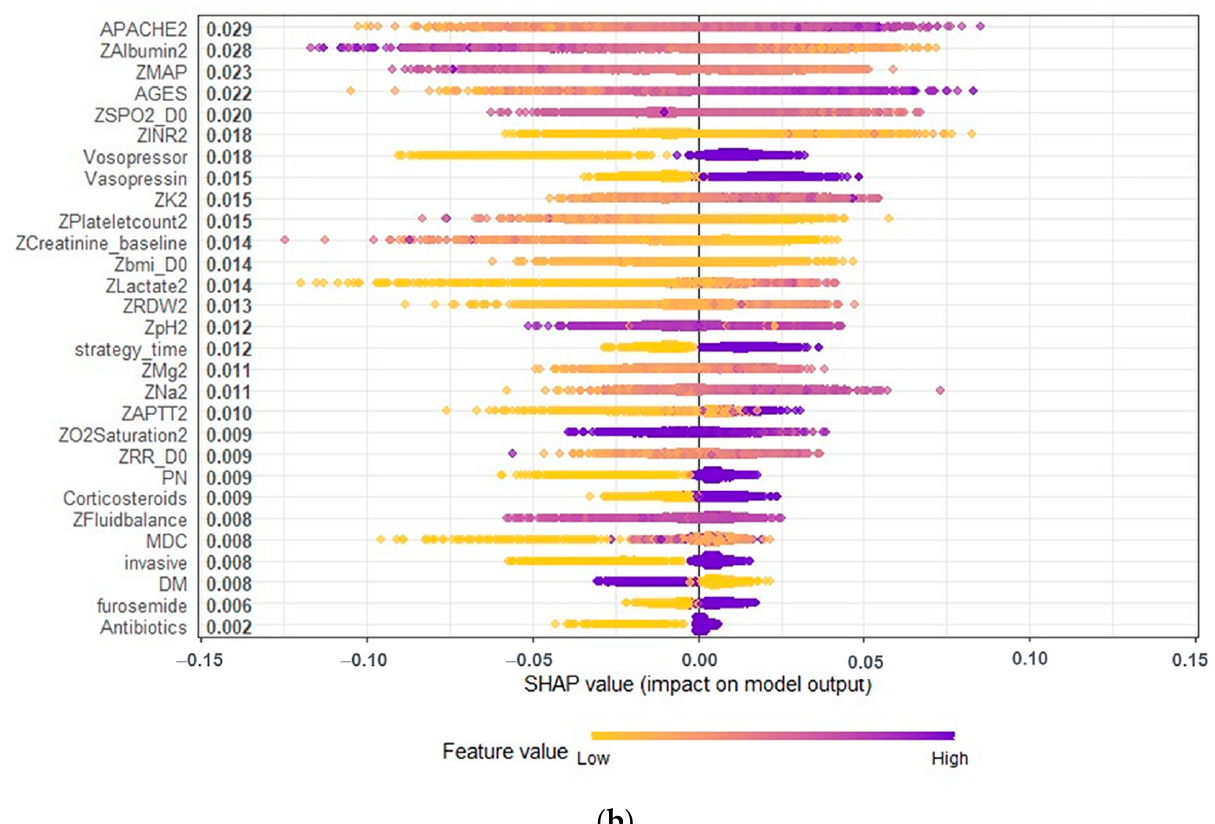
Figure A3. Summary SHapley Additive exPlanations (SHAP) plot. ( a ) Global feature importance in final random forest model output. ( b ) Relationship between features and in-hospital mortality in random forest model. Diversion on x -axis represents effect on model output, with colors used to represent low (yellow) to high (purple) value of predictors.